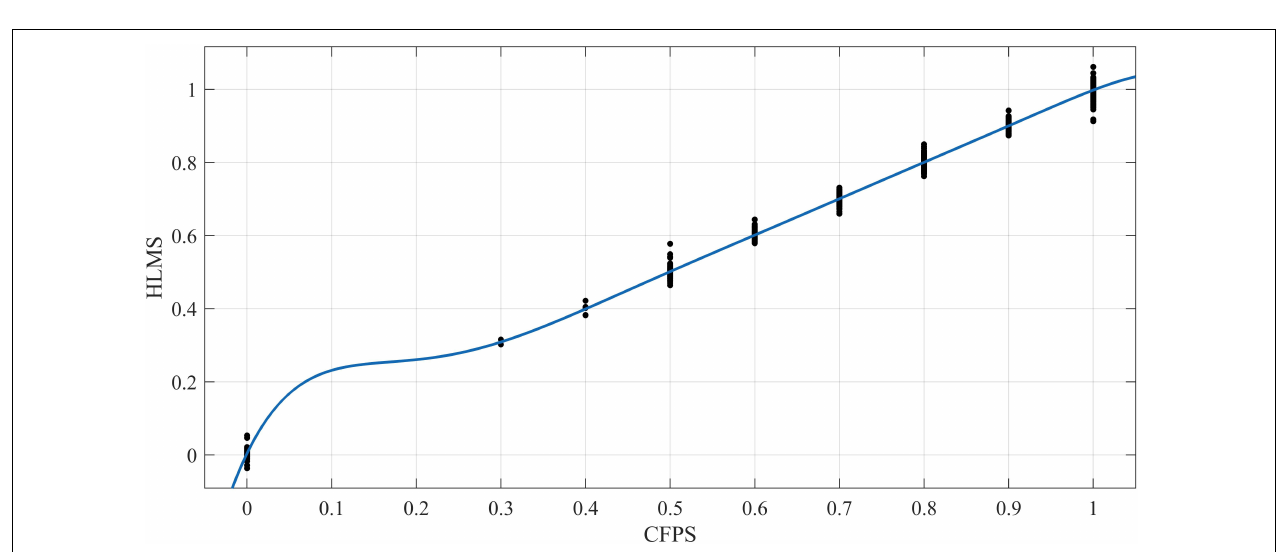
FIGURE 2 | The figure fits the Fourier curves of CFPS data and HLMS data. The software reports that the SSE is 0.345, the R-square coefficient is 0.998, and the RMSE is 0.008. These three indicators all reveal that the HLMS algorithm has a good fitting degree with the truth curve, and the curve trend further illustrates the accuracy and effectiveness of the HLMS